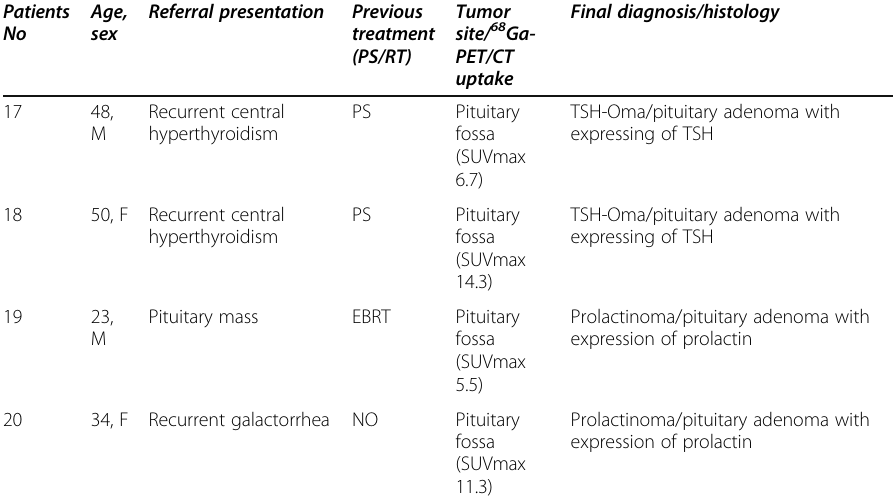
Table 2 Summary of tumor characteristic and finding (Continued) Patients